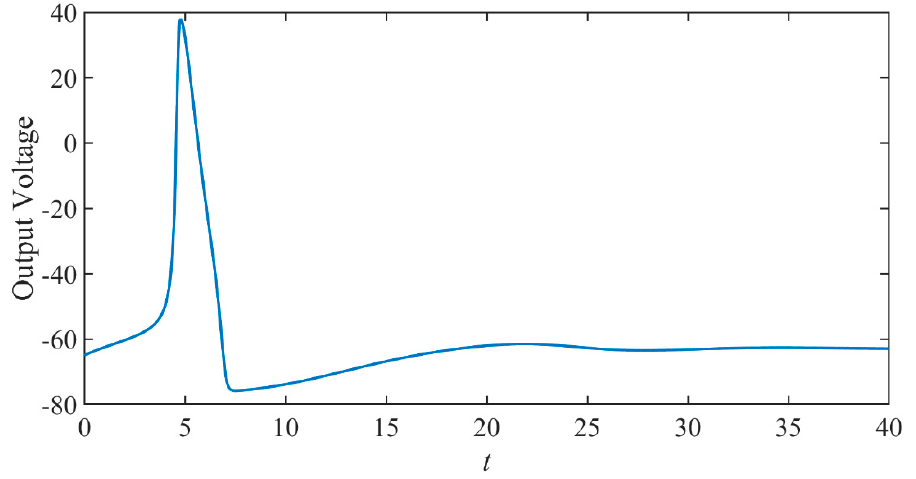
Figure 3. The response is when the input is greater than the threshold.